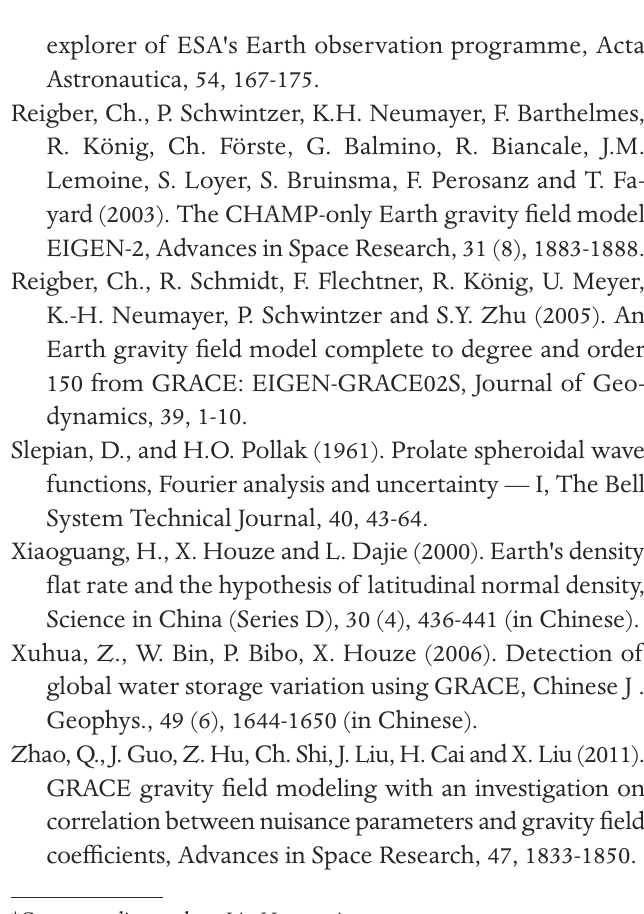
Figure 14. The signal strength of third-degree spherical harmonics at different co-latitudes (longitude, m = r